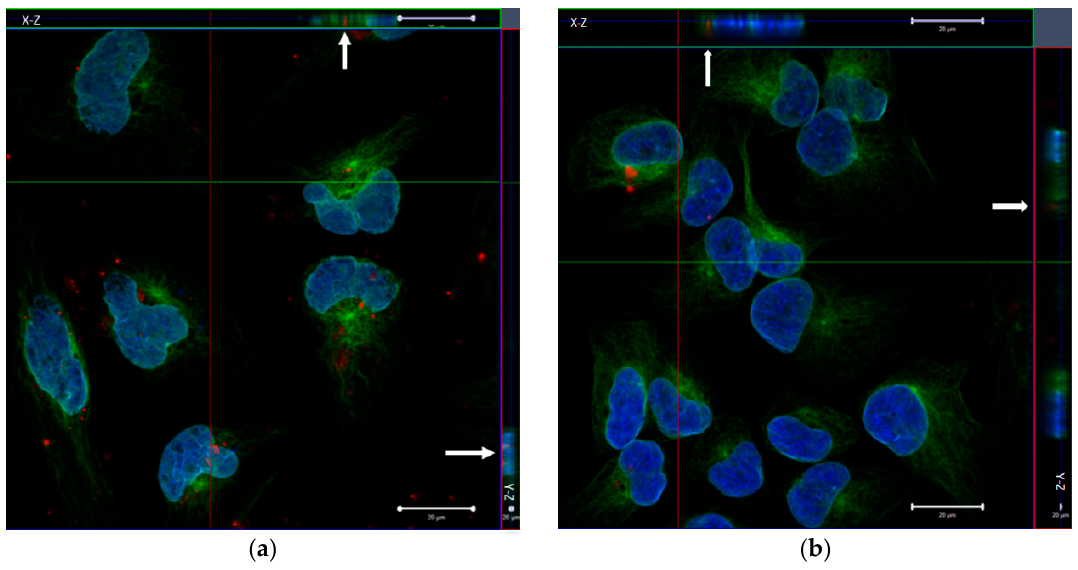
Figure 7. Cellular internalization of siRNA-MCM-41 + APTES + PCL conjugates. Rhodamine-siRNA- MCM-41 + APTES + PCL is in red, α -tubulin is in green, Lamin B1 is in cyan, and nucleus is stained with Hoechst in blue. Representative image of serial optical sections collected for three-dimensional reconstruction; x-z sections are shown at the top, and y-z sections are shown at the right of image. siRNA-MCM-41 + APTES + PCL co-localizes with α -tubulin, as indicated by yellow overlay (White arrows). Scale bar = 20 μ m. ( a ) Cellular uptake of fluorescent rhodamine-siRNA-MCM-41 + APTES + PCL in HeLa cells; ( b ) Cellular uptake of fluorescent rhodamine-siRNA-MCM-41 + APTES + PCL in HeLa cells in another field.